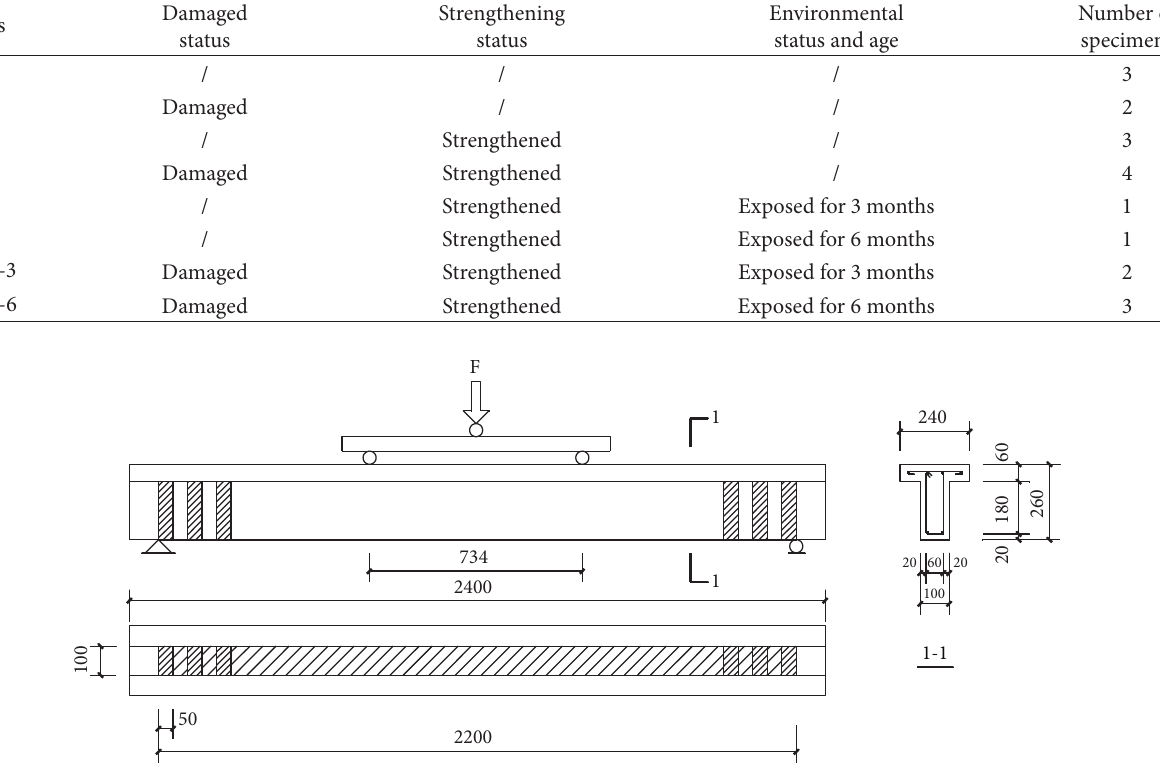
Figure 1: Details of the specimen (mm).